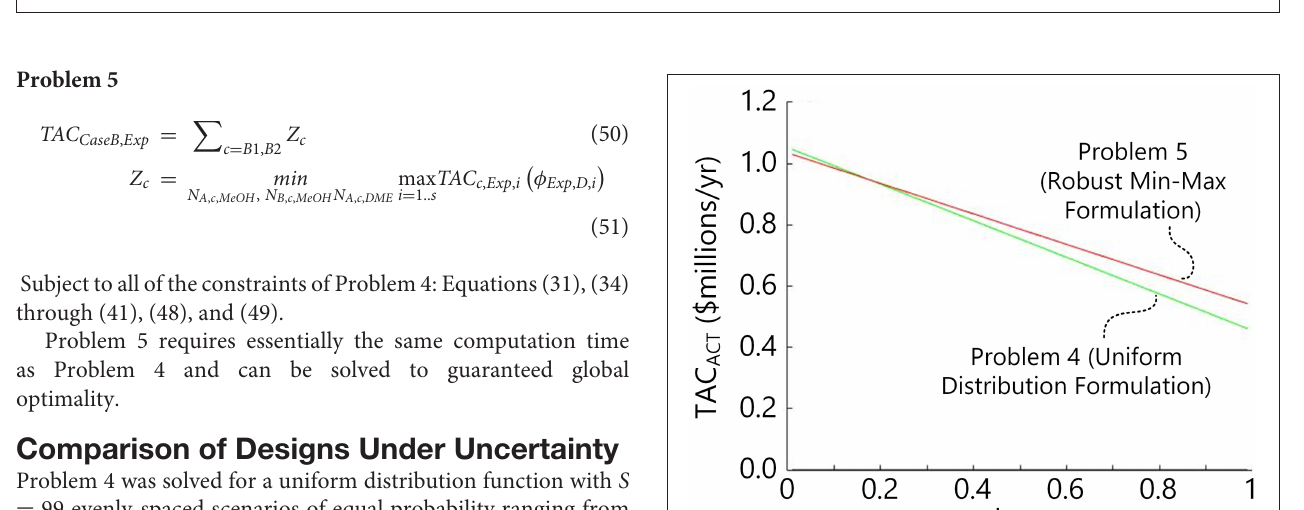
FIGURE 9 | The actual TAC for Flexible Case B ( TAC CaseB , Act ) as a function of the expected time spent in DME mode ( φ Exp , D ) and the actual time spent in DME mode ( φ Act , D ) if designed naïvely without consideration of uncertainty.